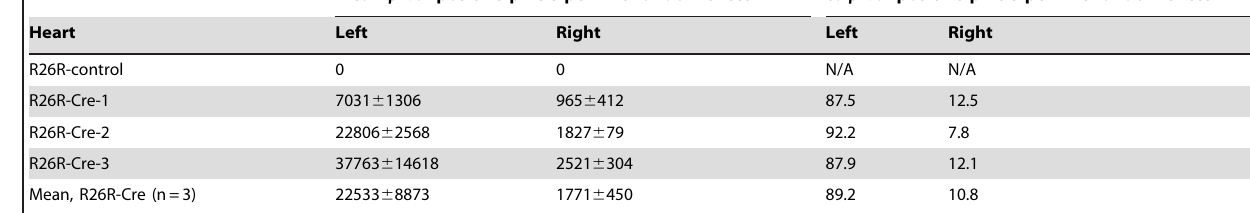
Mean b -Gal positive pixels per five random slices Left Right Left Right